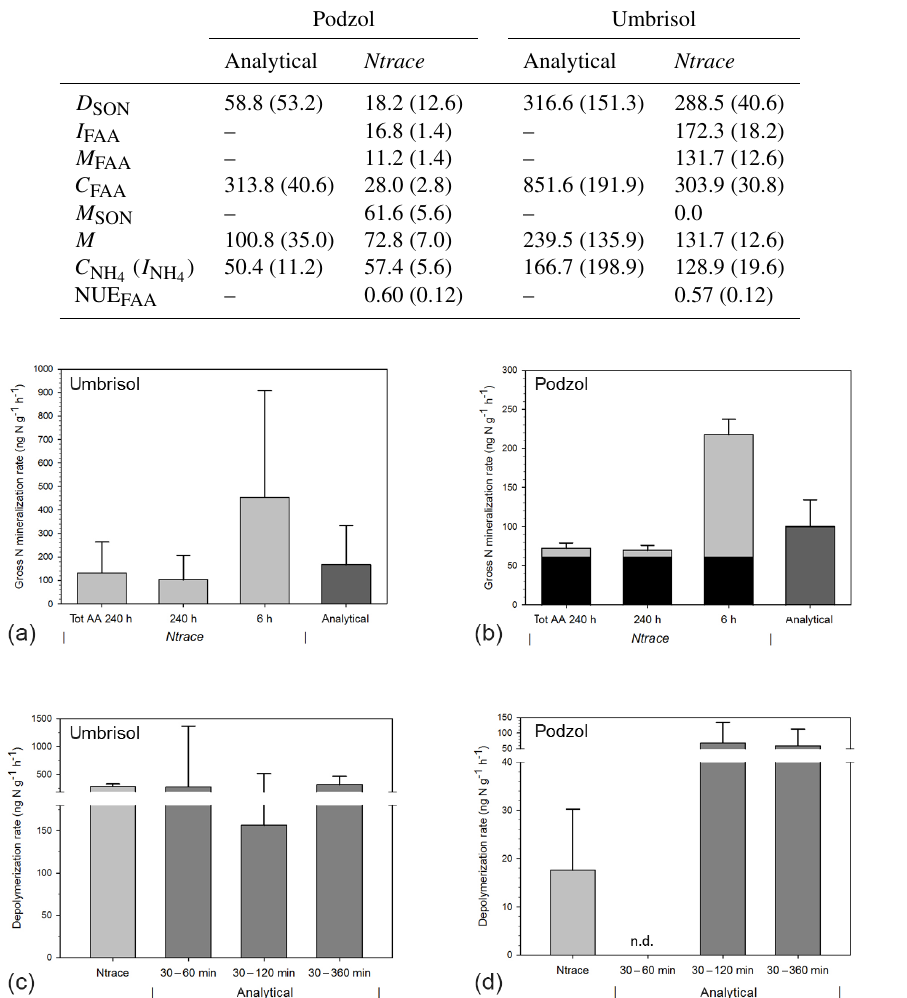
Figure 5. N transformation rates obtained by numerical modelling ( Ntrace ) and analytical equations. Gross N mineralization rates (ngNg − 1 h − 1 ) indicated as average with deviation ( n = 5) for Umbrisol (a) and Podzol (b) ; from the Ntrace model as sum of M SON (black; note that, in Umbrisol, M SON is zero) and M FAA (light grey). “Tot AA 240h” is calculated for all 20AAs over 240h; “240h” is cal- culated for the 16 measurable AAs over 240h, and “6h” is calculated for the 16 measurable AAs for the initial 6h. “Analytical” (dark grey): from the analytical equation for the time step 0 to 24h. Depolymerization rate (total) in ngNg − 1 h − 1 as average with standard deviation ( n = 5), for Umbrisol (c) and Podzol (d) from Ntrace model or at the time steps “30–60min” (for Podzol this is not determined (n.d.) due to unchanged 15 N in all replicates), “30–120min”, and “30–360min” from the analytical